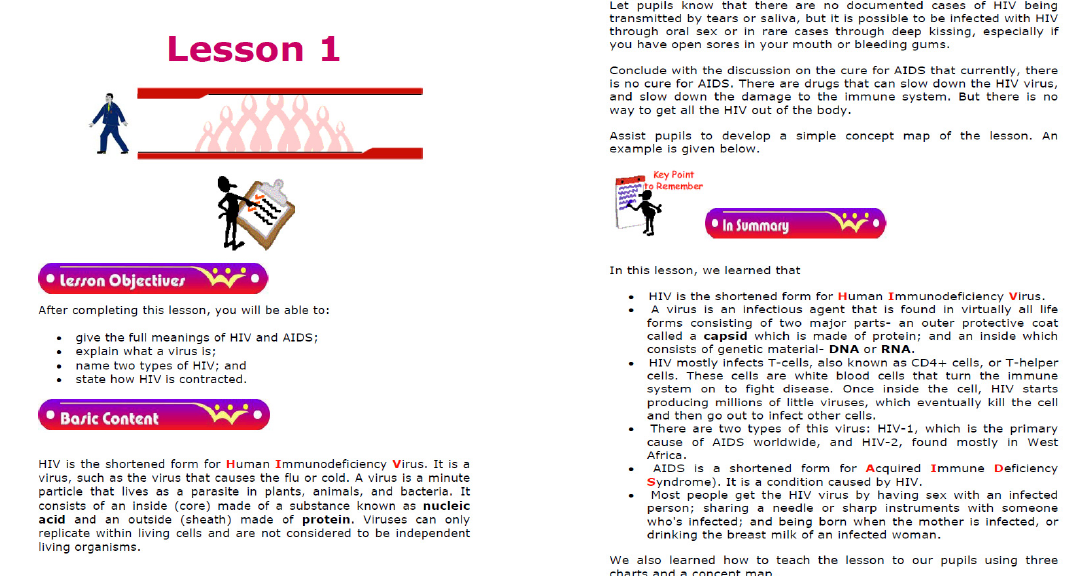
Figure 1 . VIHEAF online lesson (source: